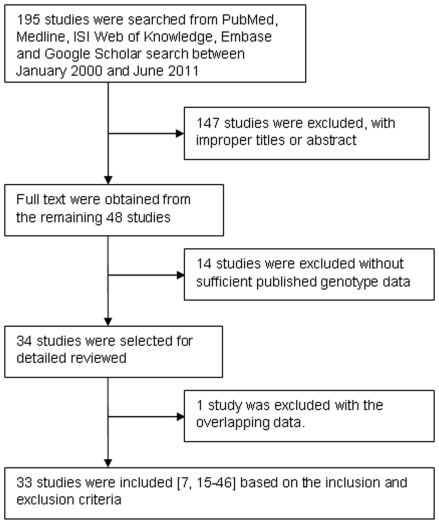
Flow diagram of study identification.